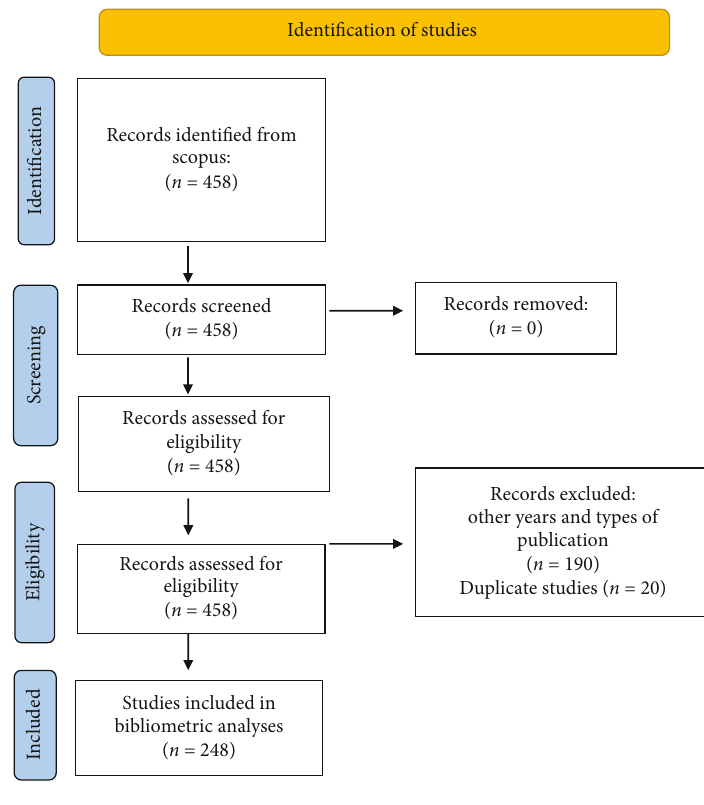
Figure 1: Flow diagram. Table 1: All knife surgery publication types per journal quartile by CiteScore Percentile. CiteScore quartile